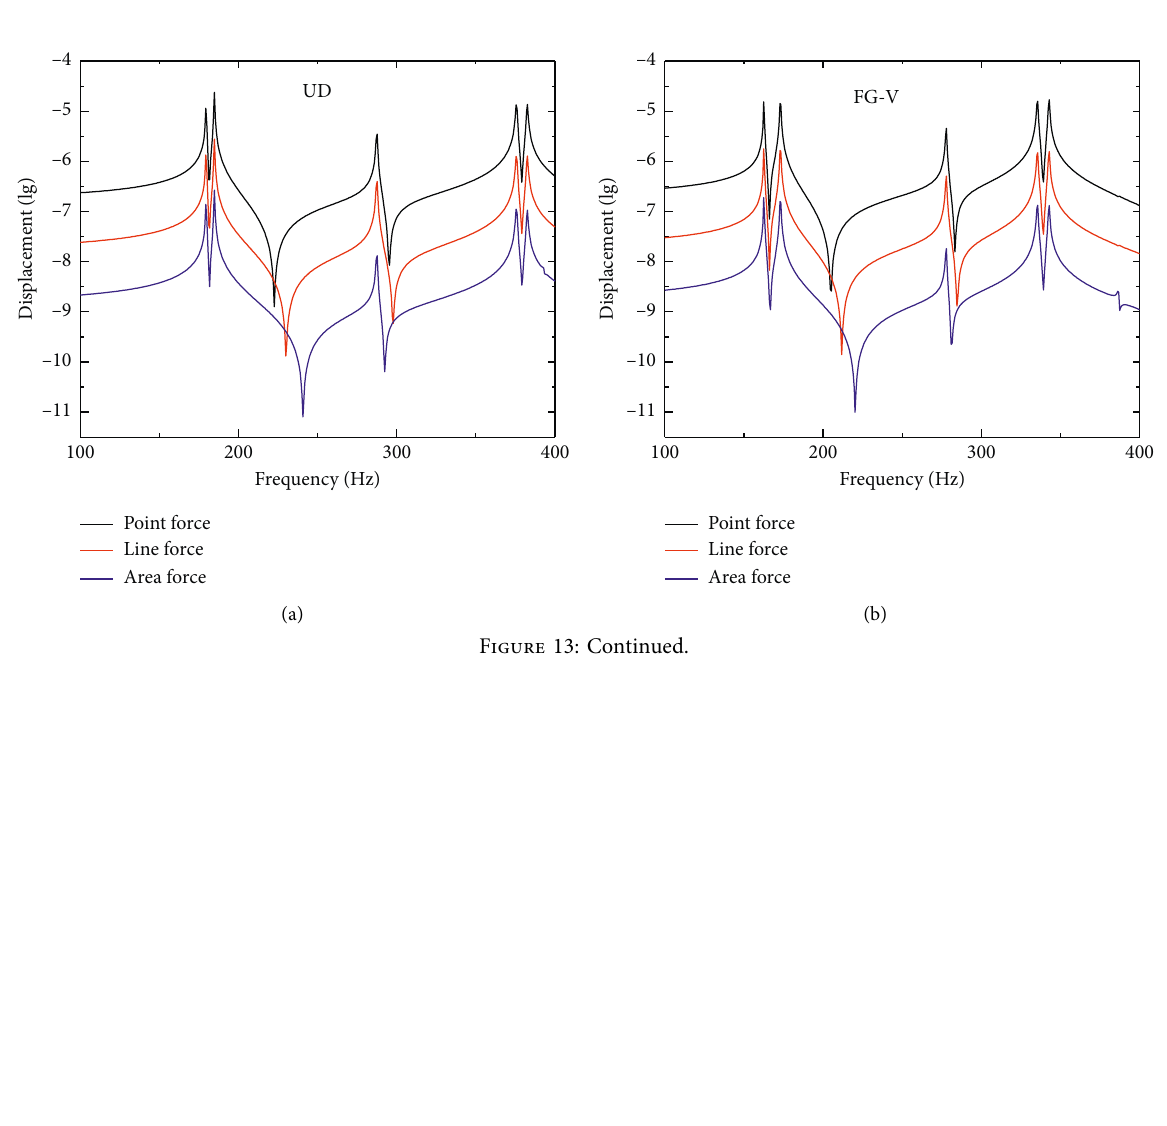
Figure 12: Some mode shapes of multi-stepped FG-CNTRC plate with CCFF boundary condition (FG-X, V ∗ η 2 =1.626, η 3 =1.138). (a) Mode1. (b) Mode2. (c)